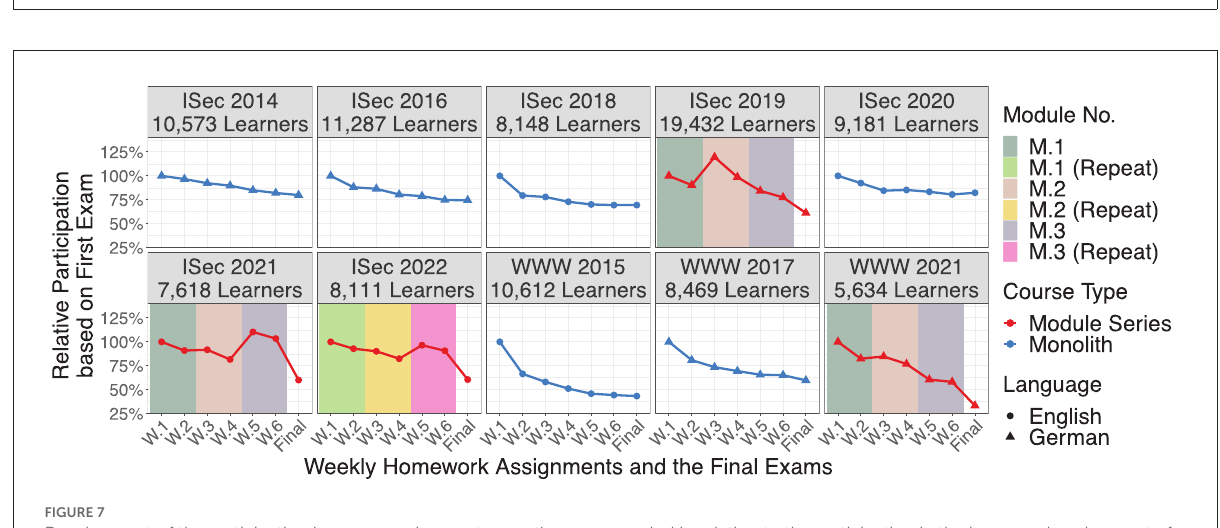
differ between the specific exam opportunity used by